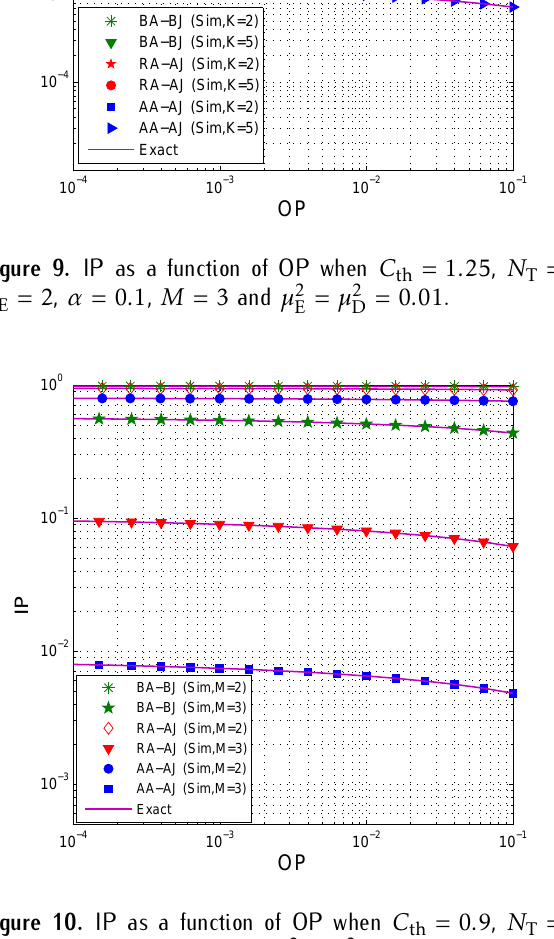
, N , th = 0 . 9 T = 2 = µ 2 = 0 . 01 E D